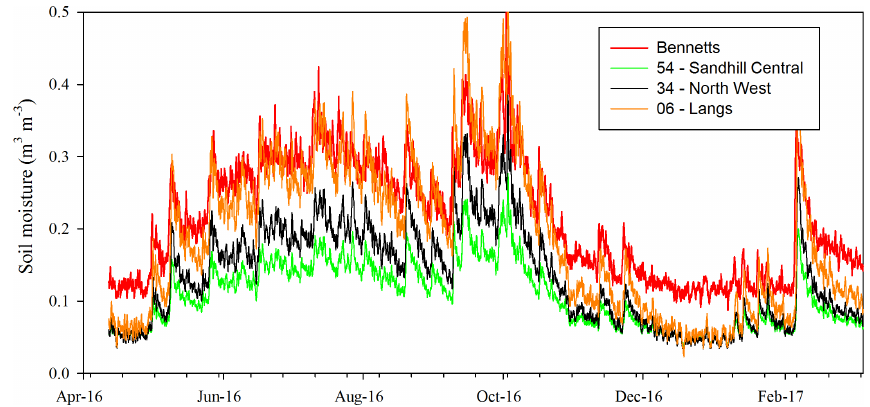
Figure 11. Time series of average soil moisture for selected properties in the intensive-scale survey area and corresponding soil moisture time series from the Bennetts cosmic-ray neutron sensor. Scaling relations ships are provided in Table